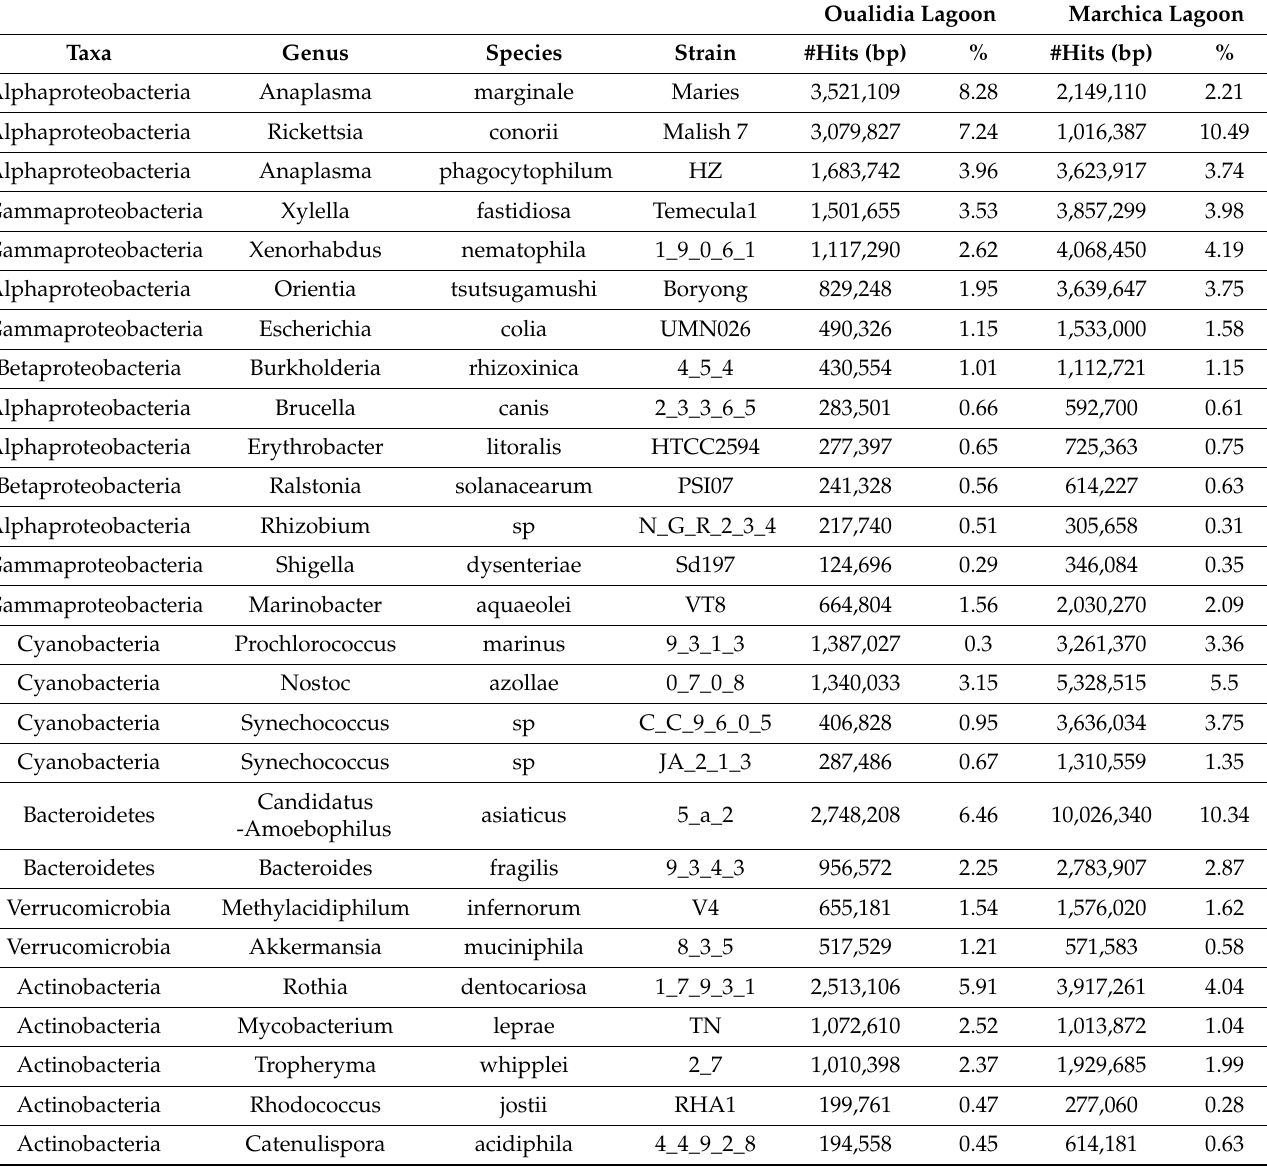
Table 6. 16S metagenome sequences assigned to a